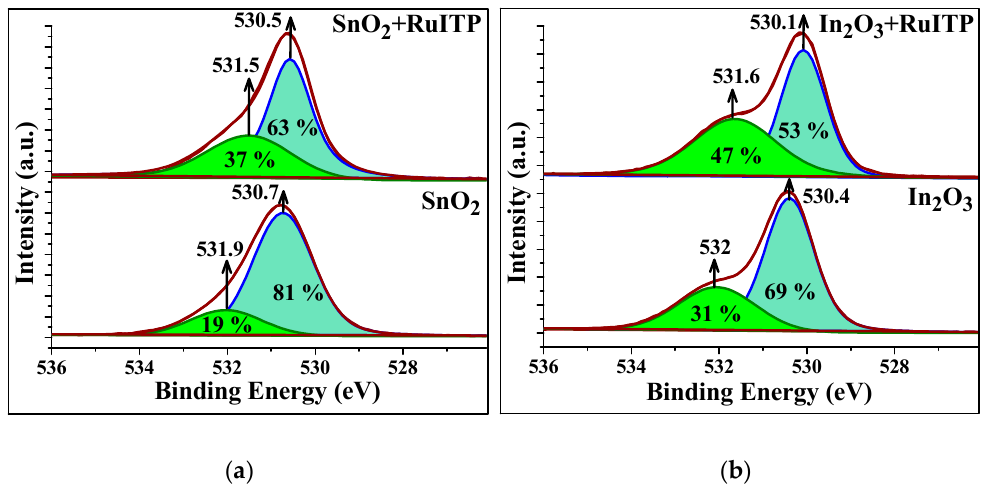
Figure 11 . X-ray photoelectron spectra O 1s of the ( a ) SnO 2 -based and ( b ) In 2 O 3 -based samples.